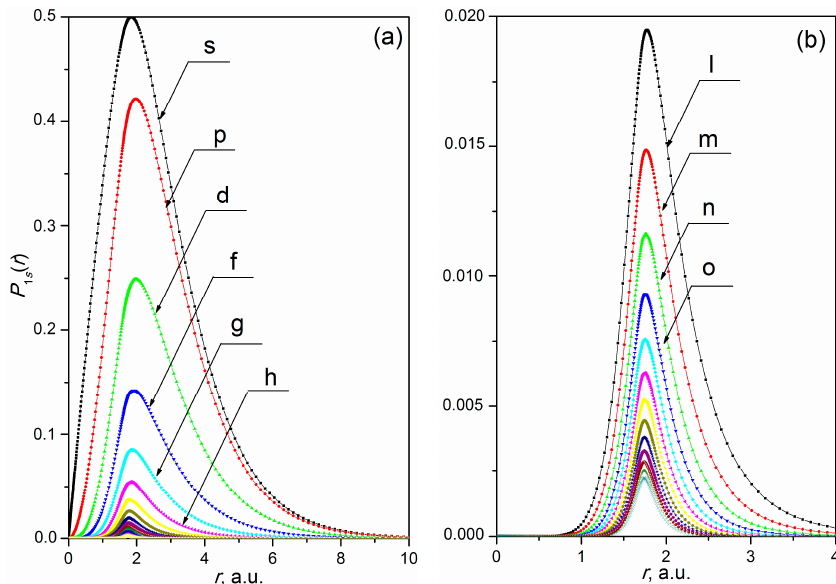
Figure 2. Radial parts of partial harmonics of SC series of H atom 1 s wave function found via a solution of Hatree-Fock equations in the molecular axis of reference: ( a ) SC expansion into series (1) with l ≤ 60; and ( b ) SC expansion into series (1) with (cid:1864) ≥ 8.